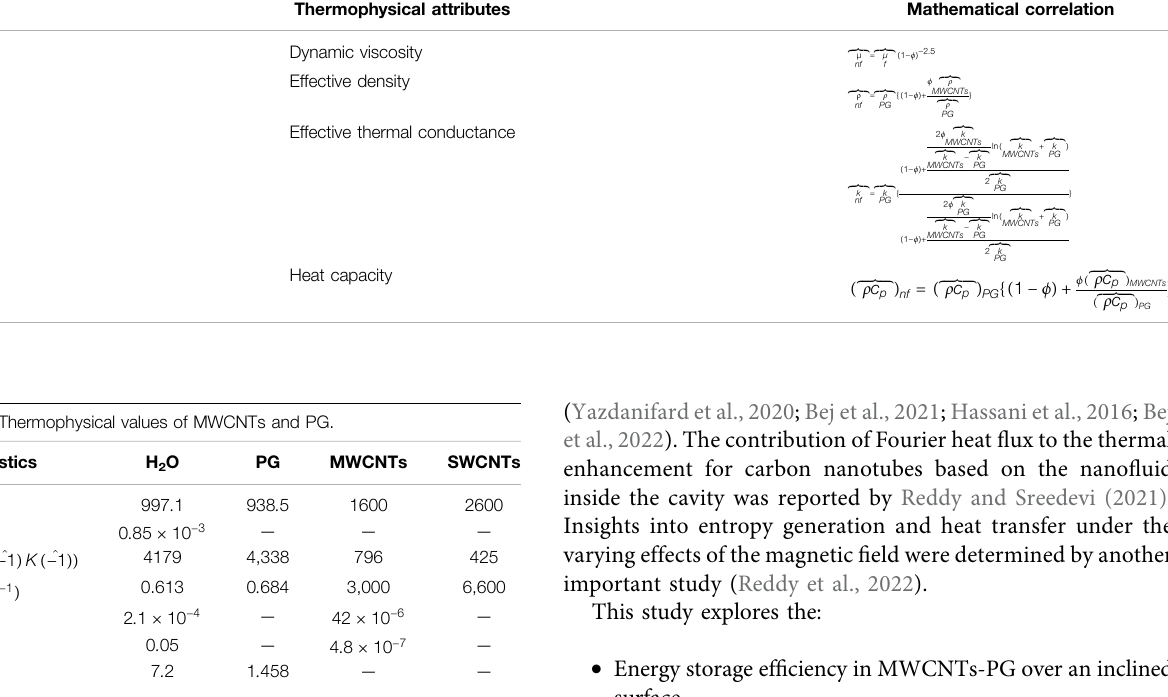
TABLE 1 | Thermophysical attributes of the nano fl uid (Ahmed et al., 2020), (Ahmed et al., 2017). S. No